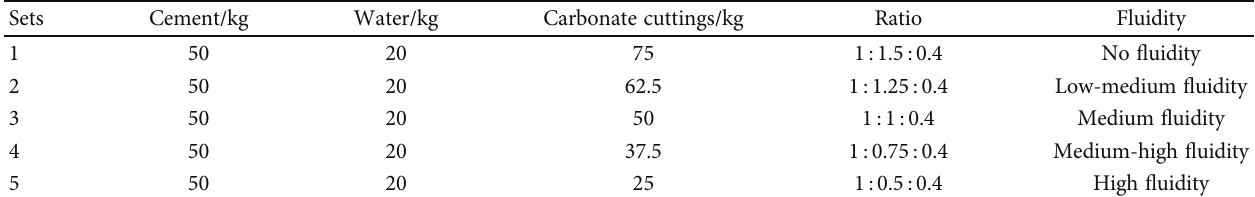
Table 1: The fl uidity of the matrix with di ff erent ratios of cement slurry and carbonate cuttings.